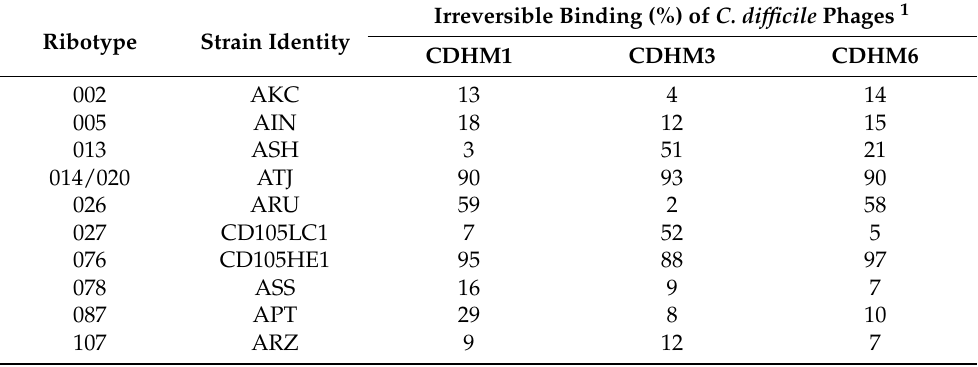
Table 2. Percentage of irreversibly bound phages calculated from the total number of phages bound to different clinically relevant C. difficile